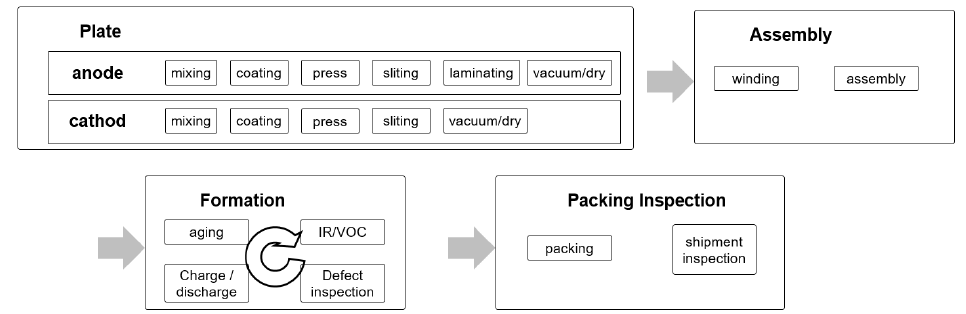
Figure 12. Battery manufacturing process.